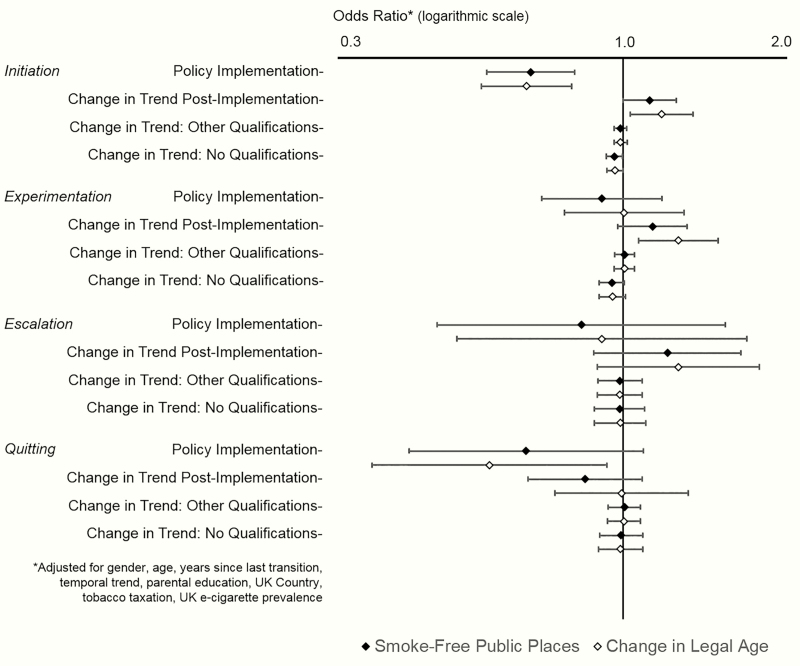
The effect of the policies on smoking transitions.